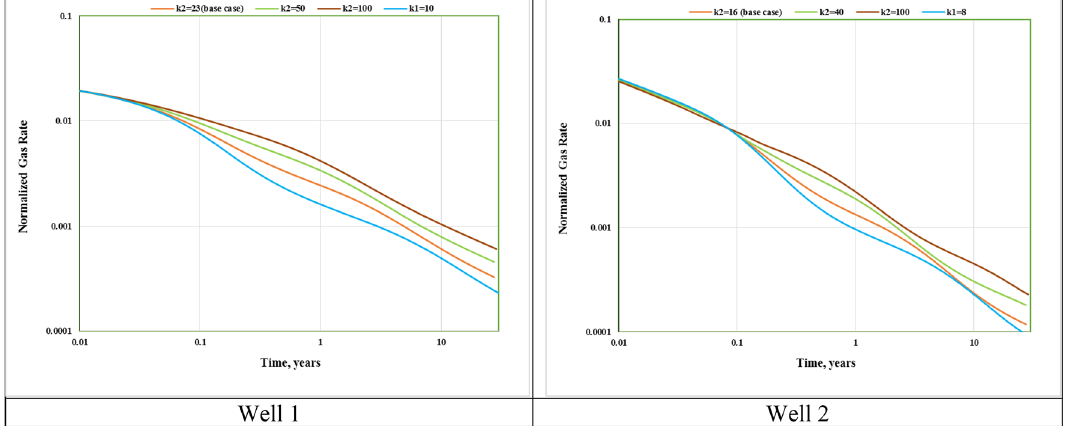
Fig. 15 Outer permeability